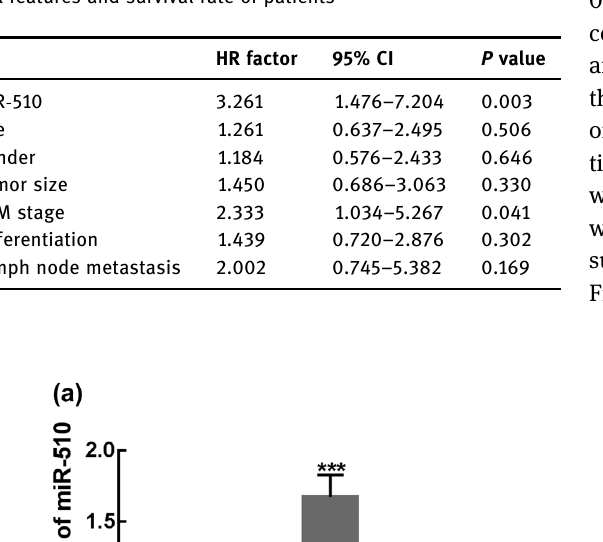
Table 2: Cox regression analysis on the association between clin - ical features and survival rate of patients